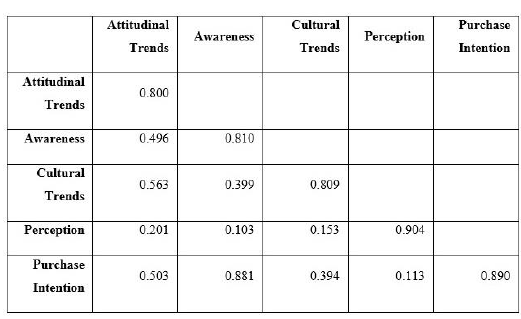
Table 3: Discriminant